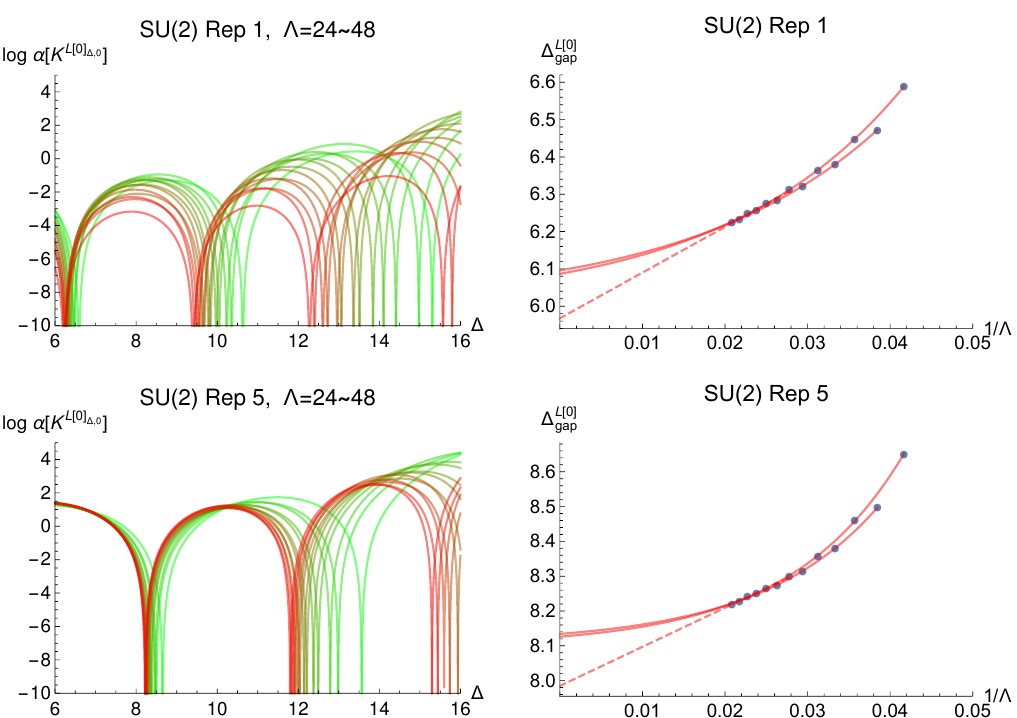
Figure 3. Left: the extremal functional optimizing the lower bound on C J for general (free or interacting) theories with SU(2) (cid:13)avor group and twist gap (cid:1) (cid:0) s (cid:21) 6, acted on the contribution of the spin-zero long multiplet to the crossing equation, (cid:11) [ K L [0] (cid:1) ; 0 ], in the 1 and 5 of SU(2), D [2] ; 3 plotted in logarithmic scale. Increasing derivative orders (cid:3) = 24 ; 26 ; : : : ; 48 are shown from green to red. Right: the gaps at di(cid:11)erent (cid:3), and extrapolations to (cid:3) ! 1 using the quadratic ansatz (5.23) for (cid:3) 2 4 Z and (cid:3) 2 4 Z + 2, separately (solid), and using the linear ansatz (5.24) (dashed).